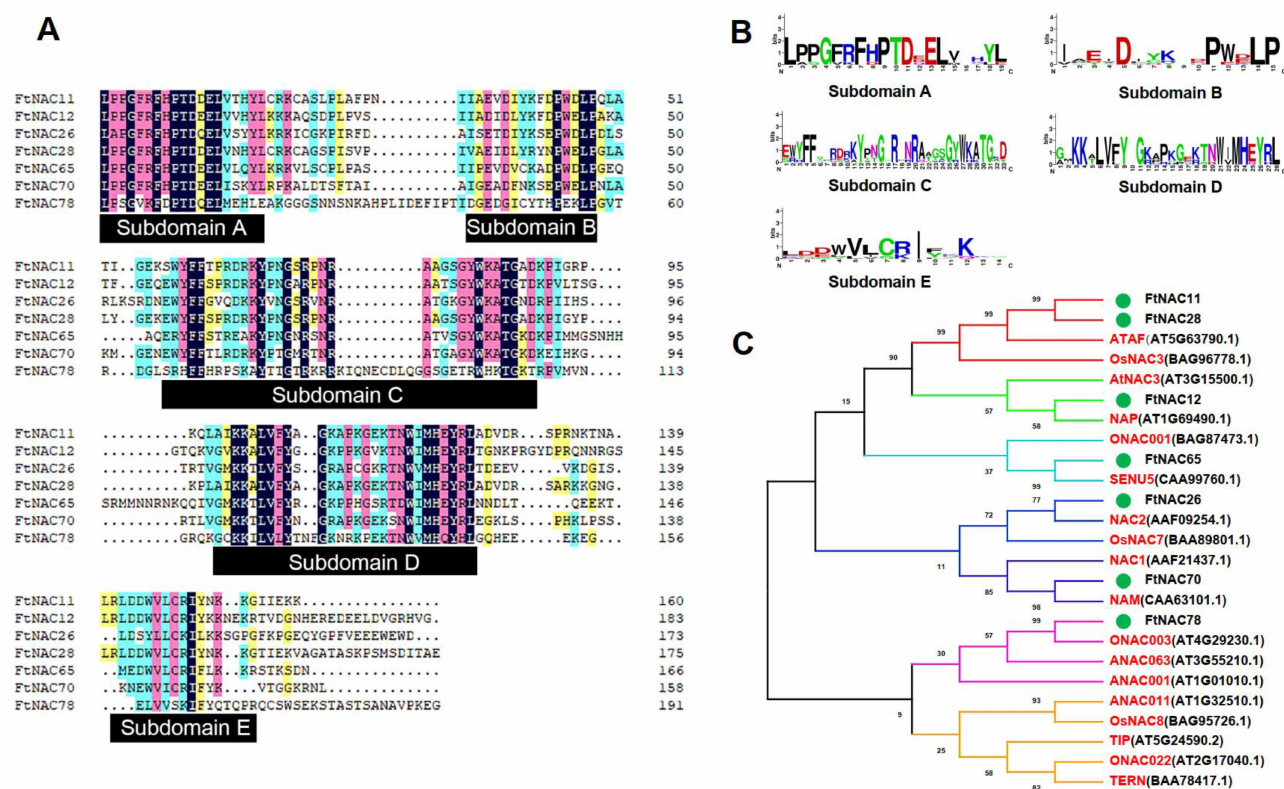
Figure 2. Amino acids and phylogenetic analyses of seven FtNAC proteins. ( A ) Multiple amino acid sequence alignments of the NAM domains in seven FtNAC proteins. Five conserved subdomains (A, B, C, D, and E) were marked by black boxes. ( B ) Sequence logos of five subdomains in NAM domain. ( C ) Phylogenetic tree of seven FtNACs (green dots) and 18 representative NAC